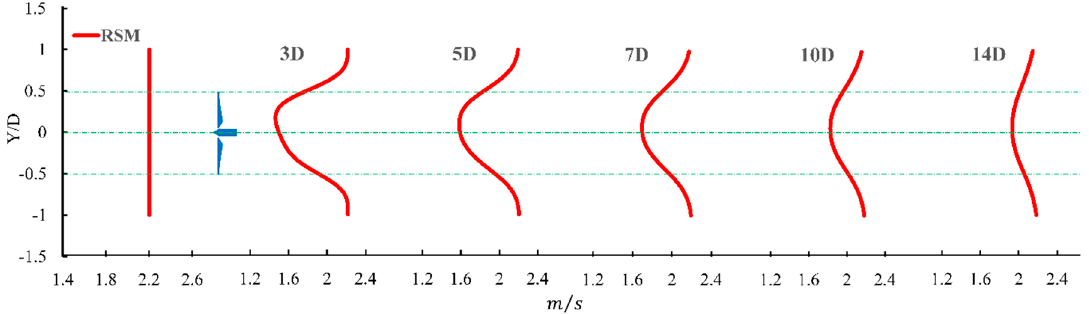
Figure 9. Horizontal distribution of stream ‐ wise velocity simulated by RSM.